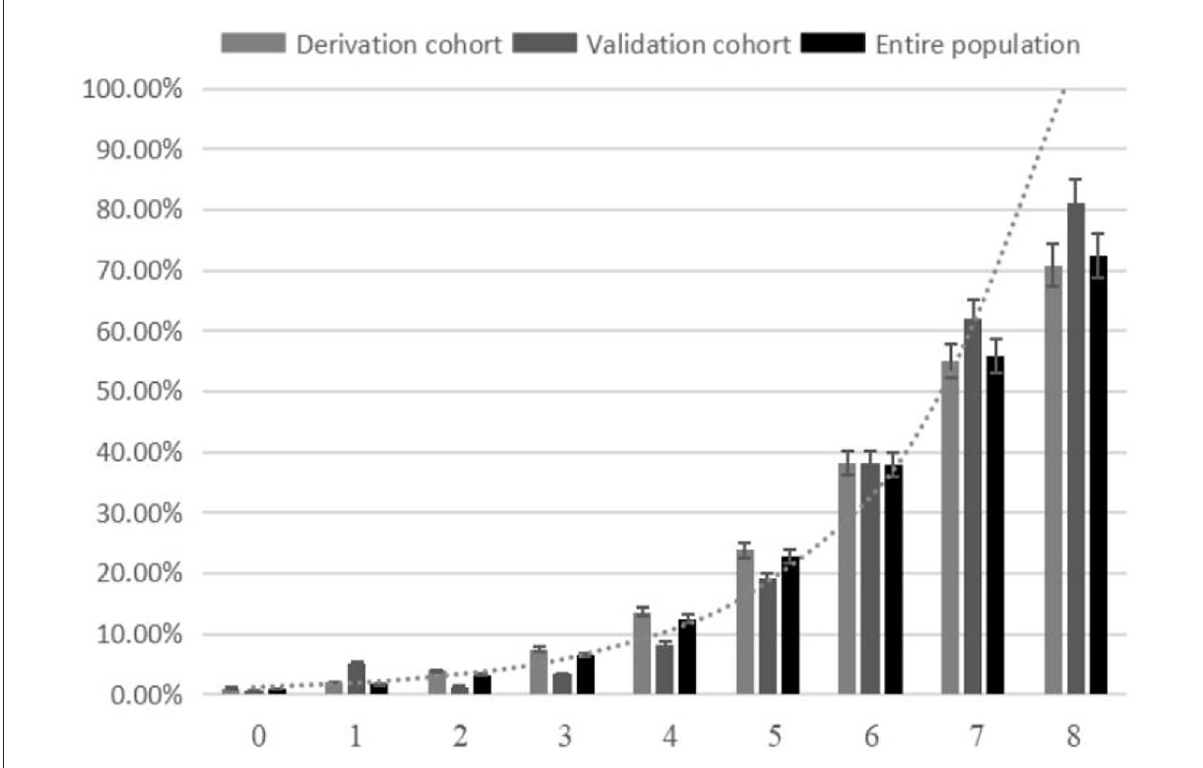
FIGURE2 Risk of sICH per SON 2 A 2 score